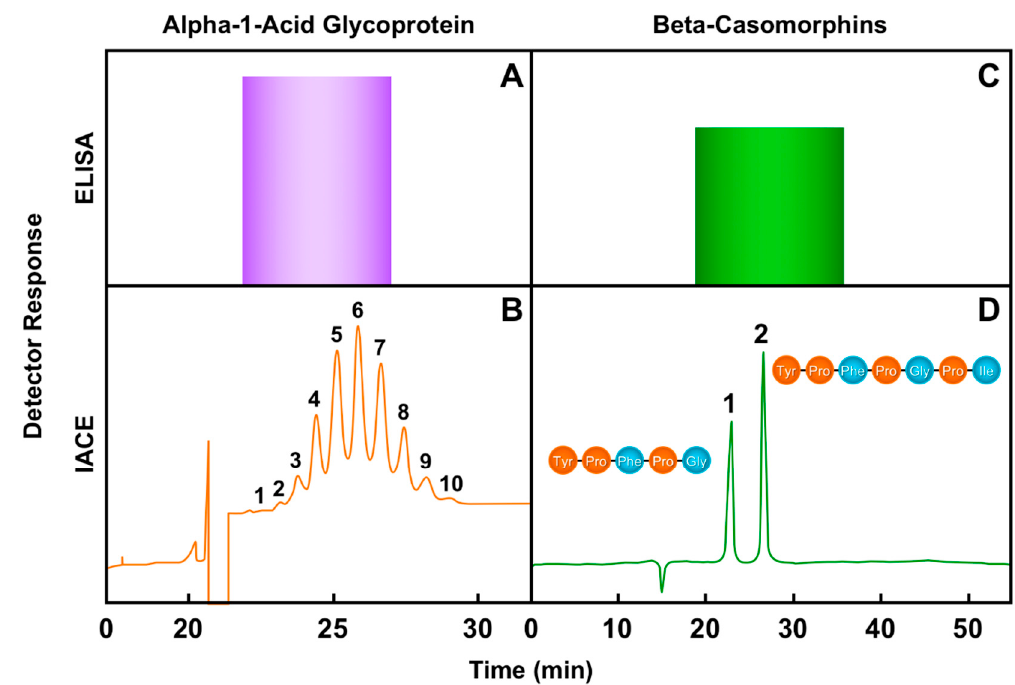
Figure 3. Schematic representation of a comparative profile of enzyme-linked immunosorbent